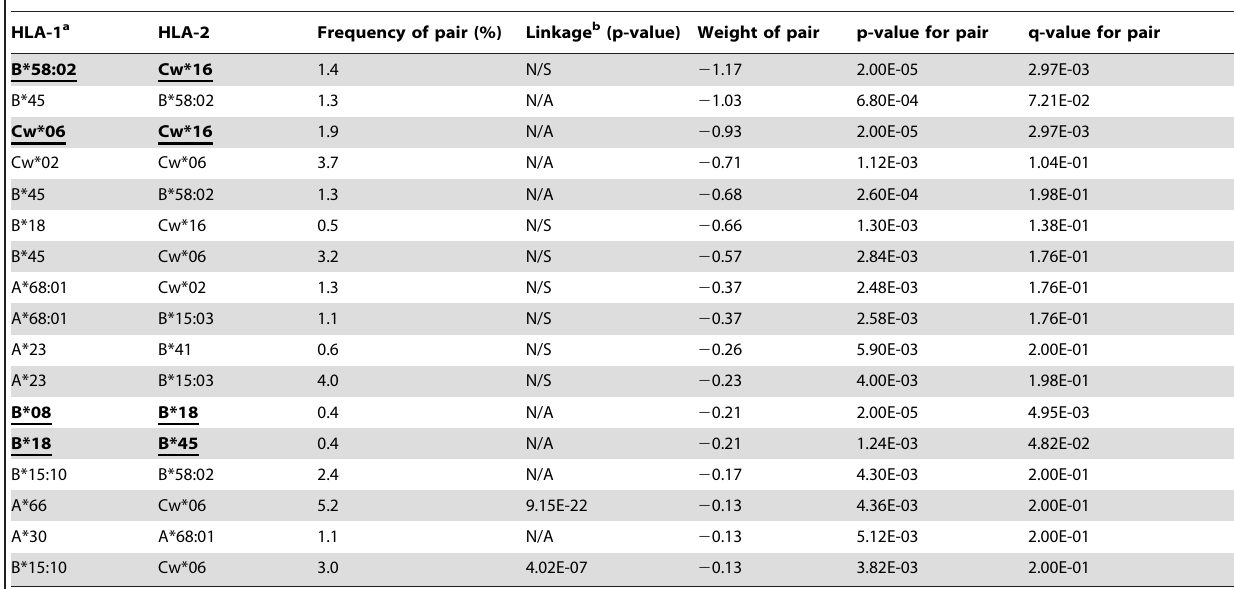
Table 5. Multivariate analysis of pairs of HLA Class I alleles, showing pairs associated with hazardous (detrimental) impact on HIV-1 disease control with respect to decline in CD4 + T cell count and/or increased viral load (q , 0.2).